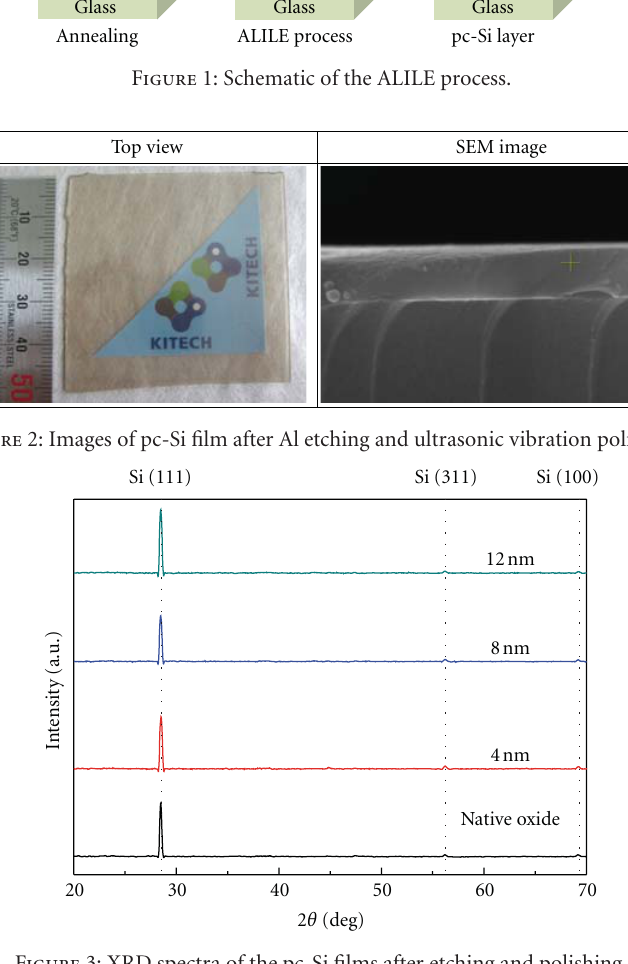
Figure 3: XRD spectra of the pc-Si films after etching and polishing. Table 1: Experimental procedure of the ALILE process.